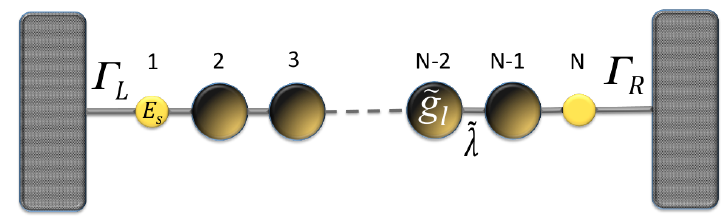
Figure 2. (color online) Representation of the effective molecule coupled with the